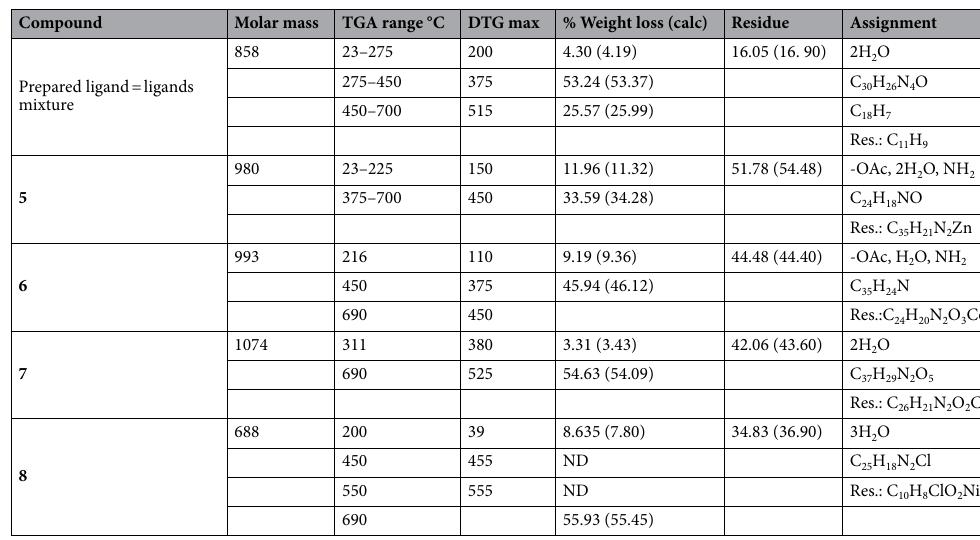
Table 1. Thermal analysis of mixed ligand 3 and their metal(II) complexes 5 – 8 .